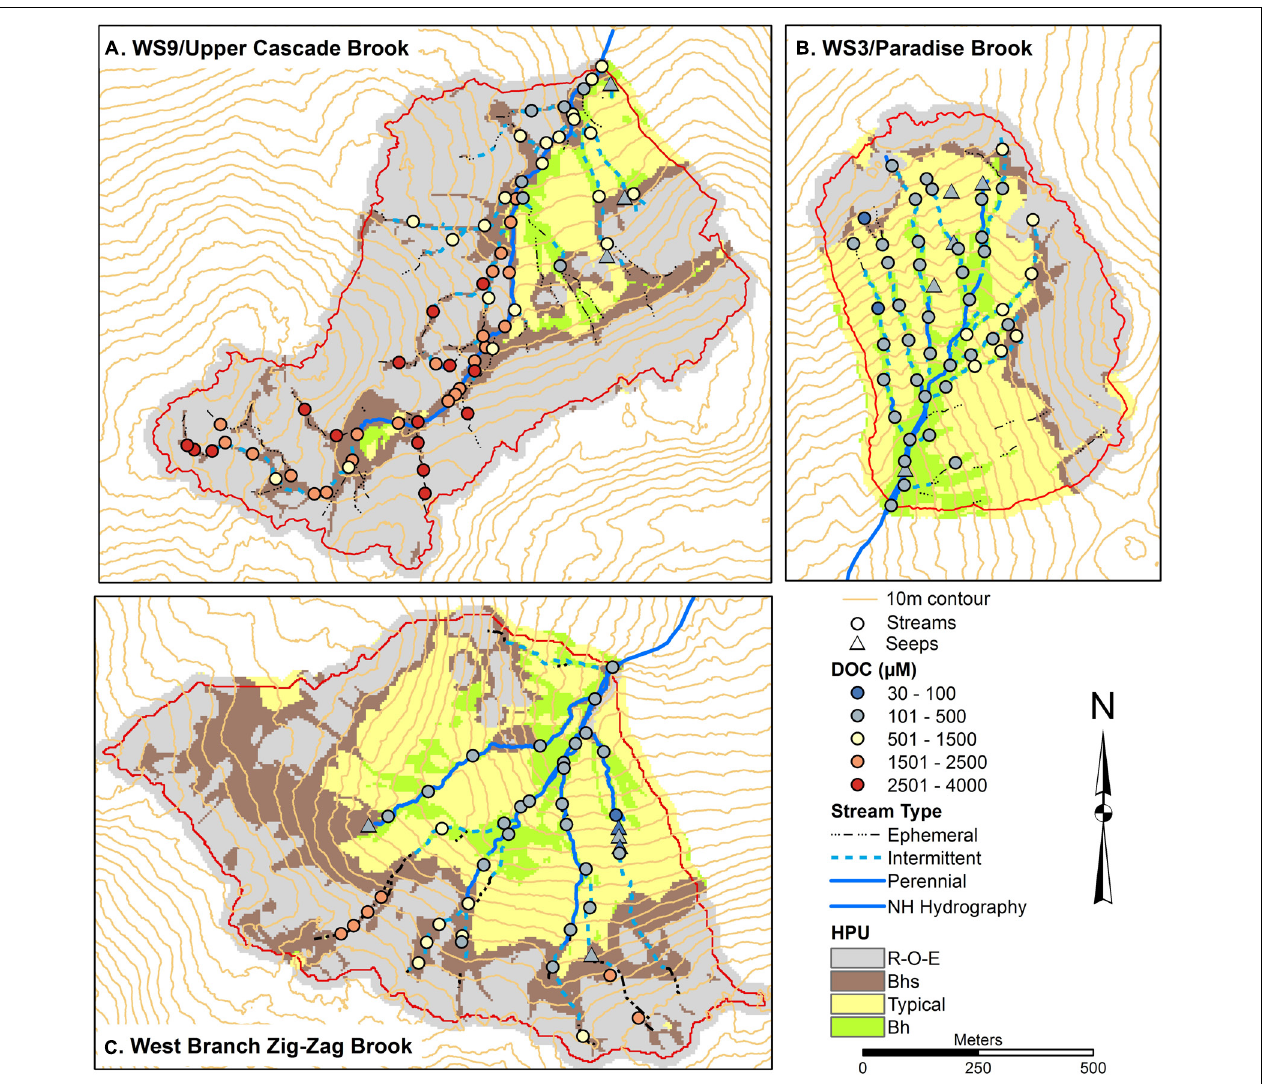
FIGURE 3 | Soils maps for W9 (A) , W3 (B) , and West Branch Zig Zag Brook (C) with variation in surface water dissolved organic carbon (DOC) concentrations from a synoptic survey conducted July 22–23, 2015. Surface water samples were classified as streams (circles) or seeps (triangles). Soil units include bedrock